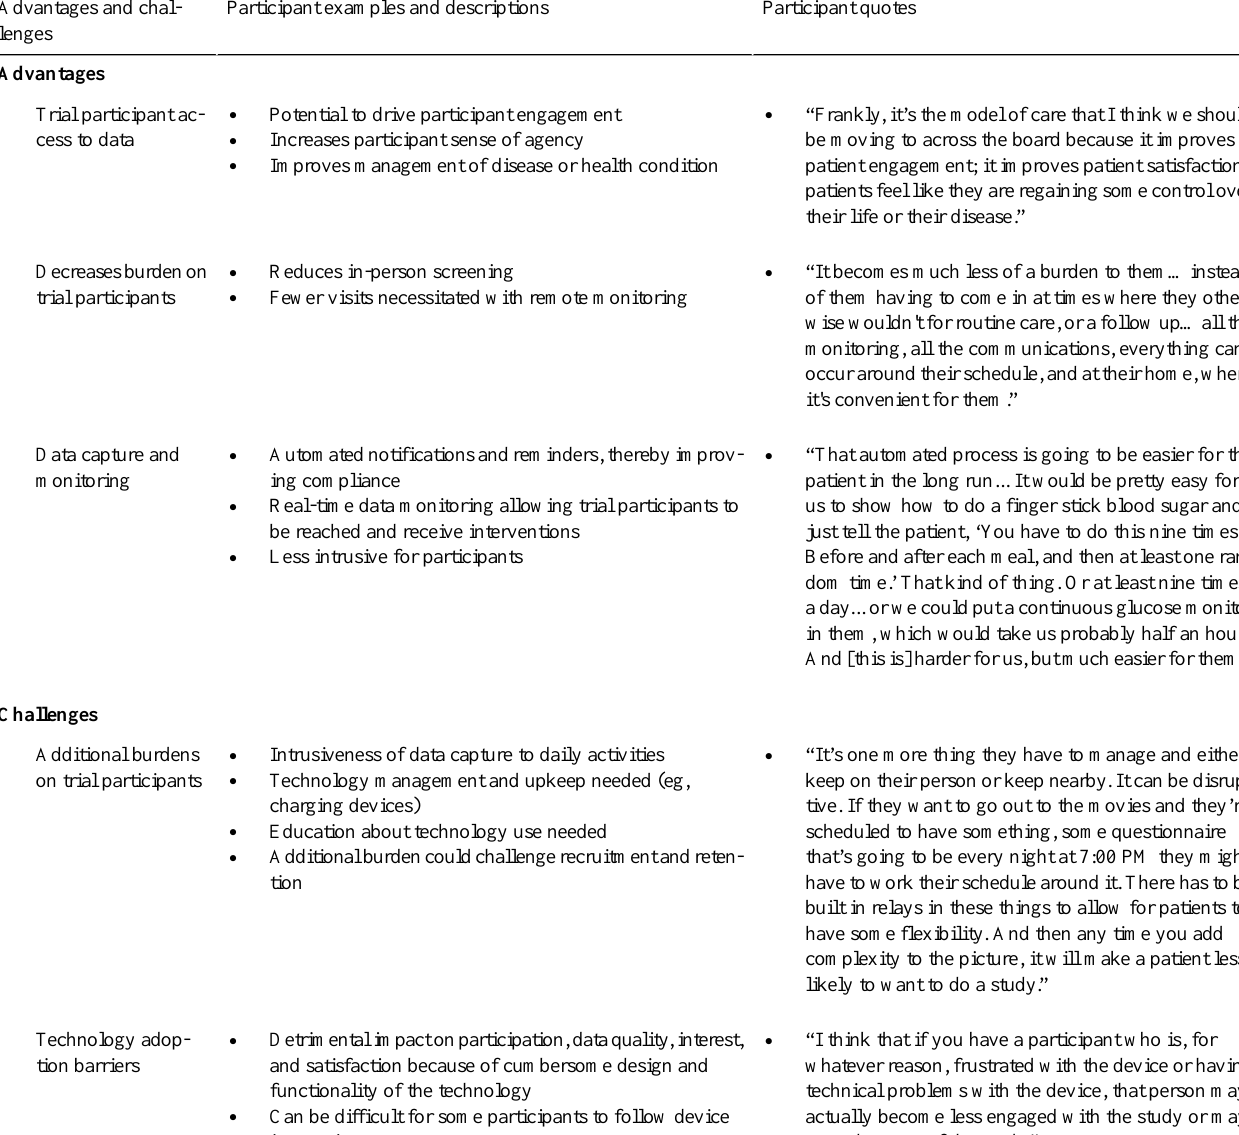
Table 6. Investigator perspectives on the advantages and challenges of mobile clinical trials for trial participants.